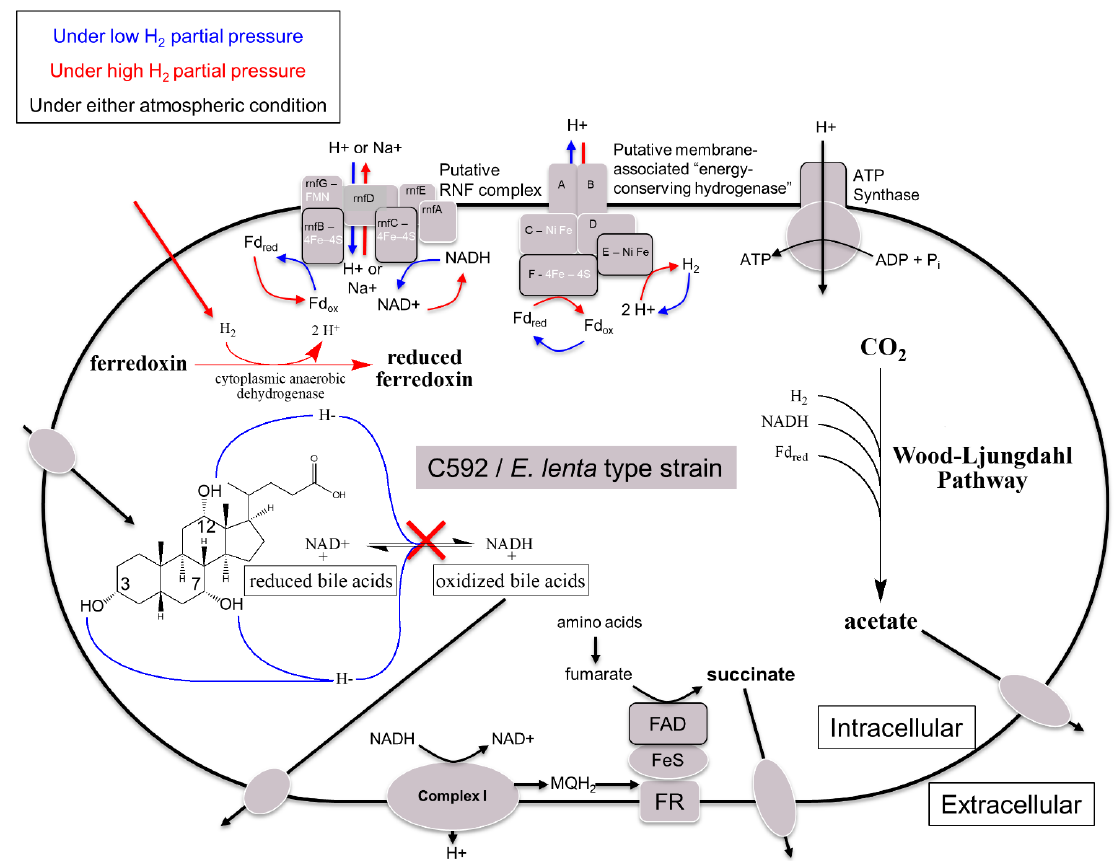
Figure 4. Proposed model for the role of Eggerthella lenta hydroxysteroid dehydrogenases: bile acid oxidation provides reductant for the Wood–Ljundahl Pathway (WLP) of acetogenesis. This model is based on biochemical and genomic data demonstrating that E. lenta strains contain complete WLP genes, and that bile acid oxidation is inhibited by a hydrogen gas atmosphere.